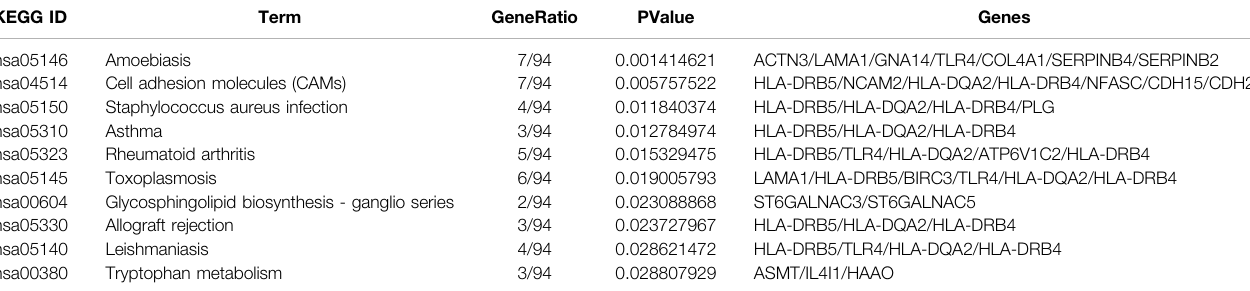
TABLE 3 | Enrichment analysis of KEGG pathway.